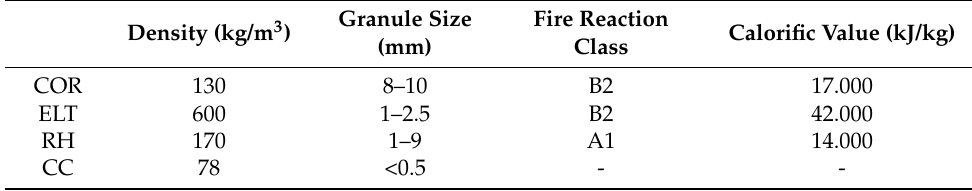
Table 1. Main characteristics of the loose materials [12,16].